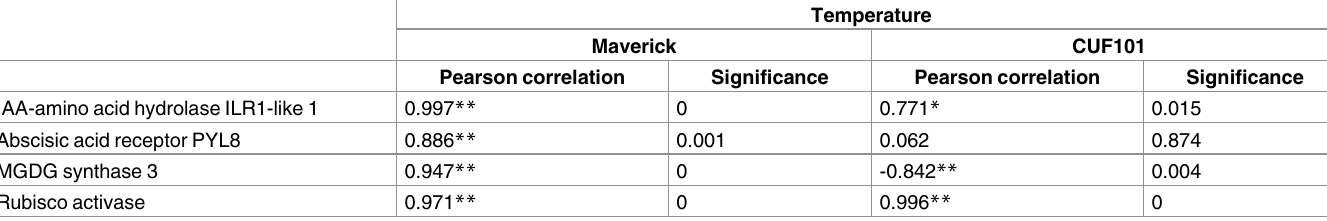
Table 6. Correlation between mRNA abundance in the leavesof Maverickand CUF101varietiesand temperature under artificial growth